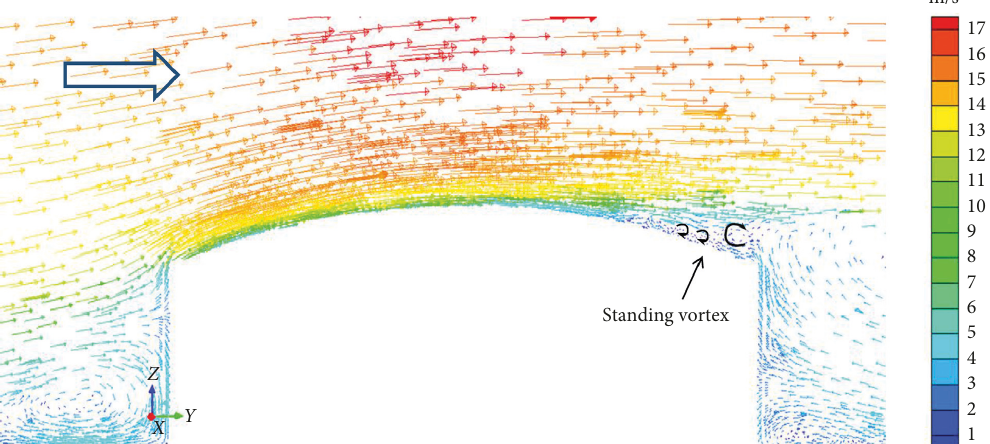
Figure 14: Wind speed vector at midsection when wind direction